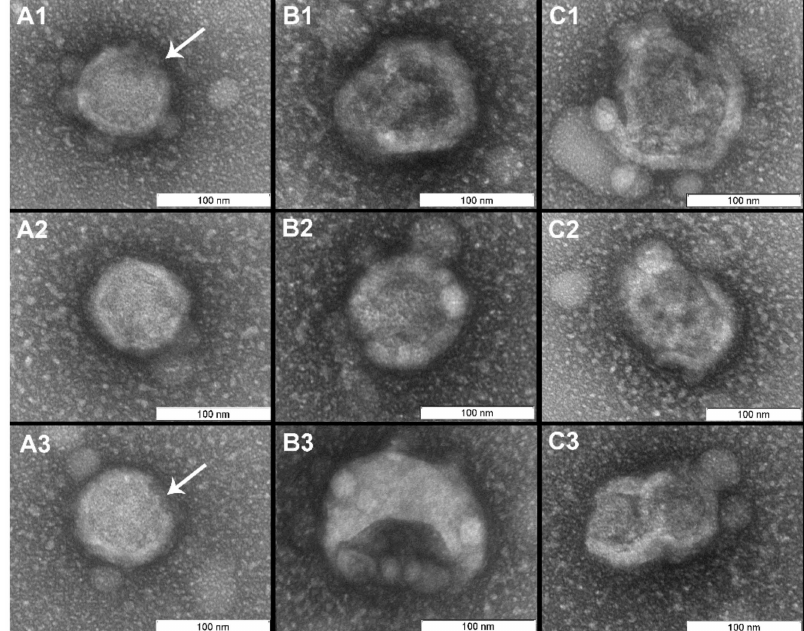
Figure 6. Virions after PDI (4 µ M photosensitizer). All virus particles are “bald”. Columns are organized according to the condition of the lipid membranes: ( A ) membranes maintained structural integrity, minor membrane damages marked with arrows; ( B ) virions with partially destroyed membranes; ( C ) membranes are destroyed and virions disintegrated. Scale bar 100 nm.